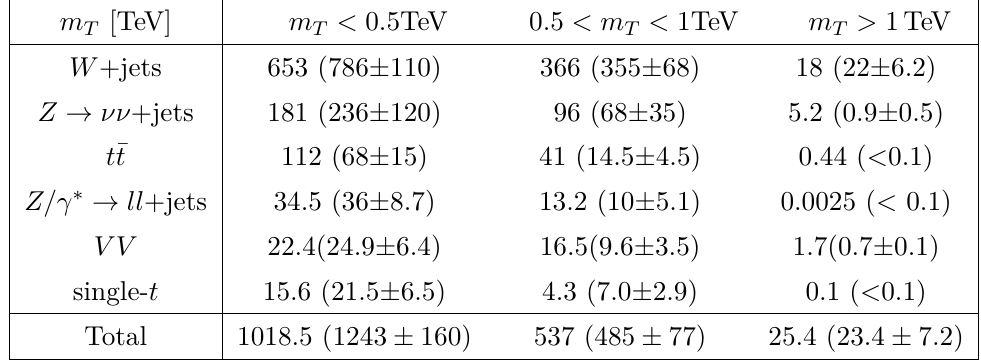
√ s = 13 TeV and an